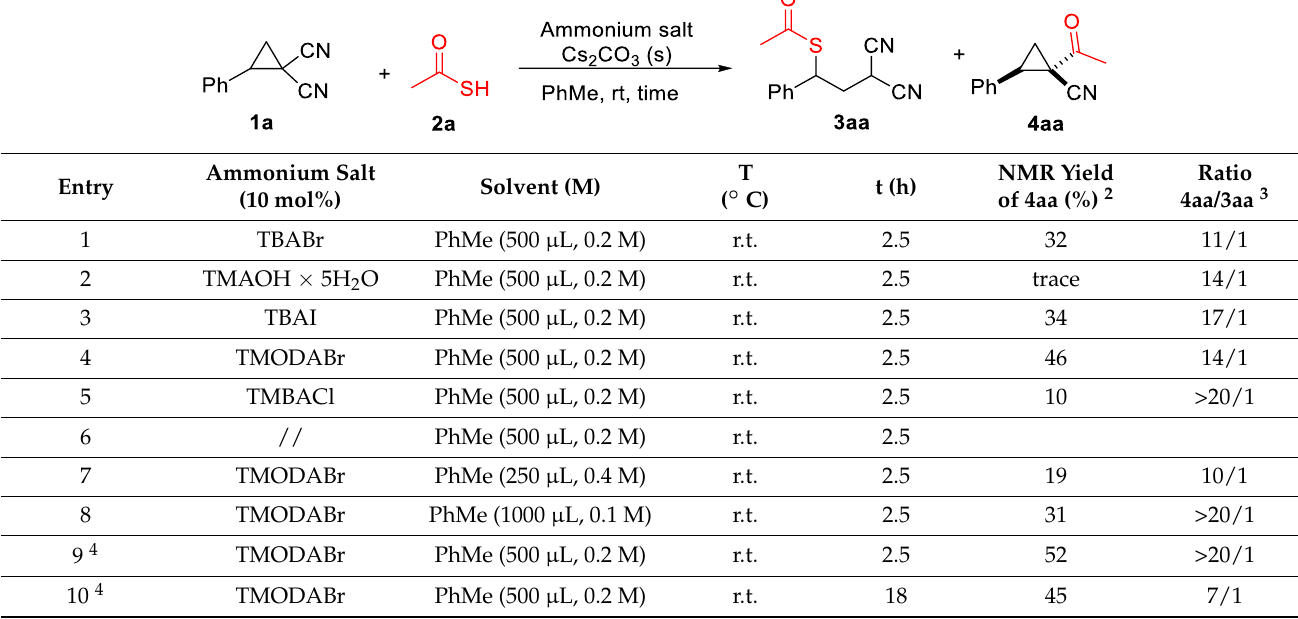
Table 1. Ammonium salt screening 1 .